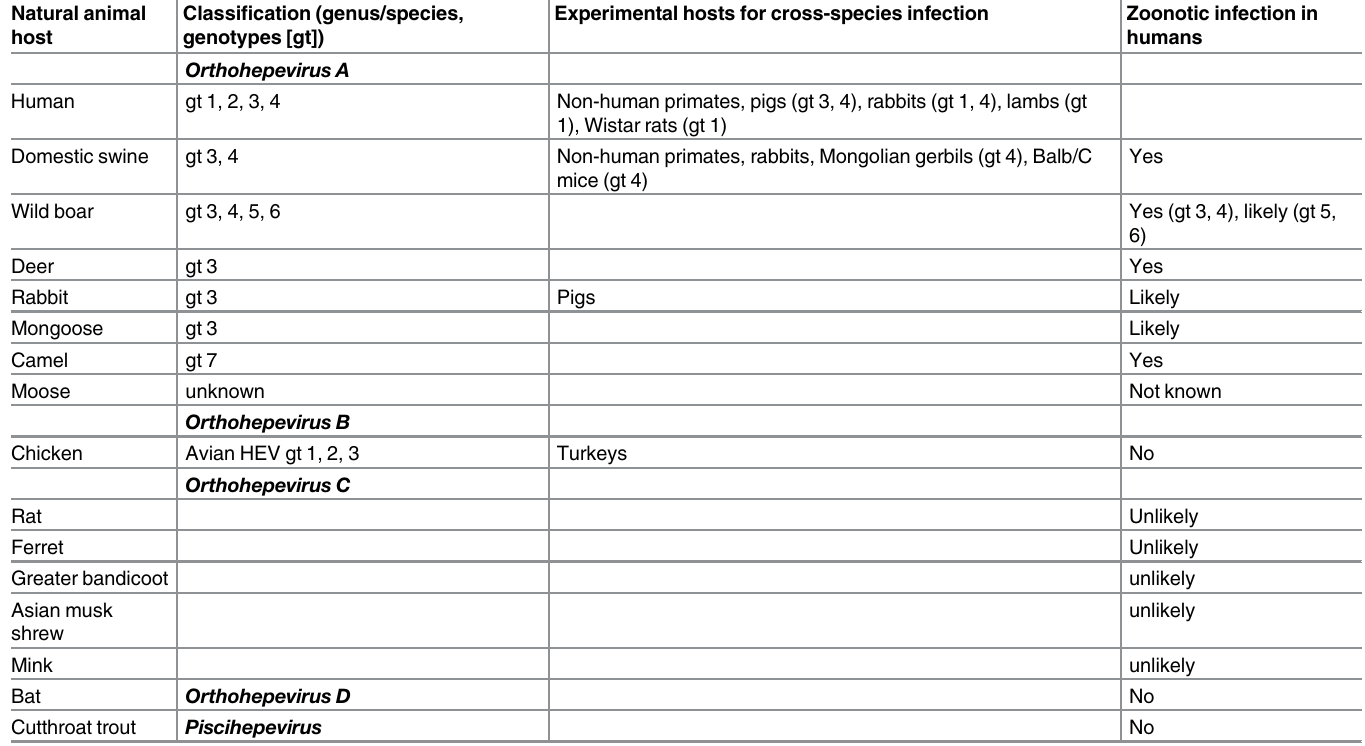
Table 1. Host range of hepatitis E virus infection and zoonotic risk. Natural animal Classi fi cation (genus/species, host genotypes